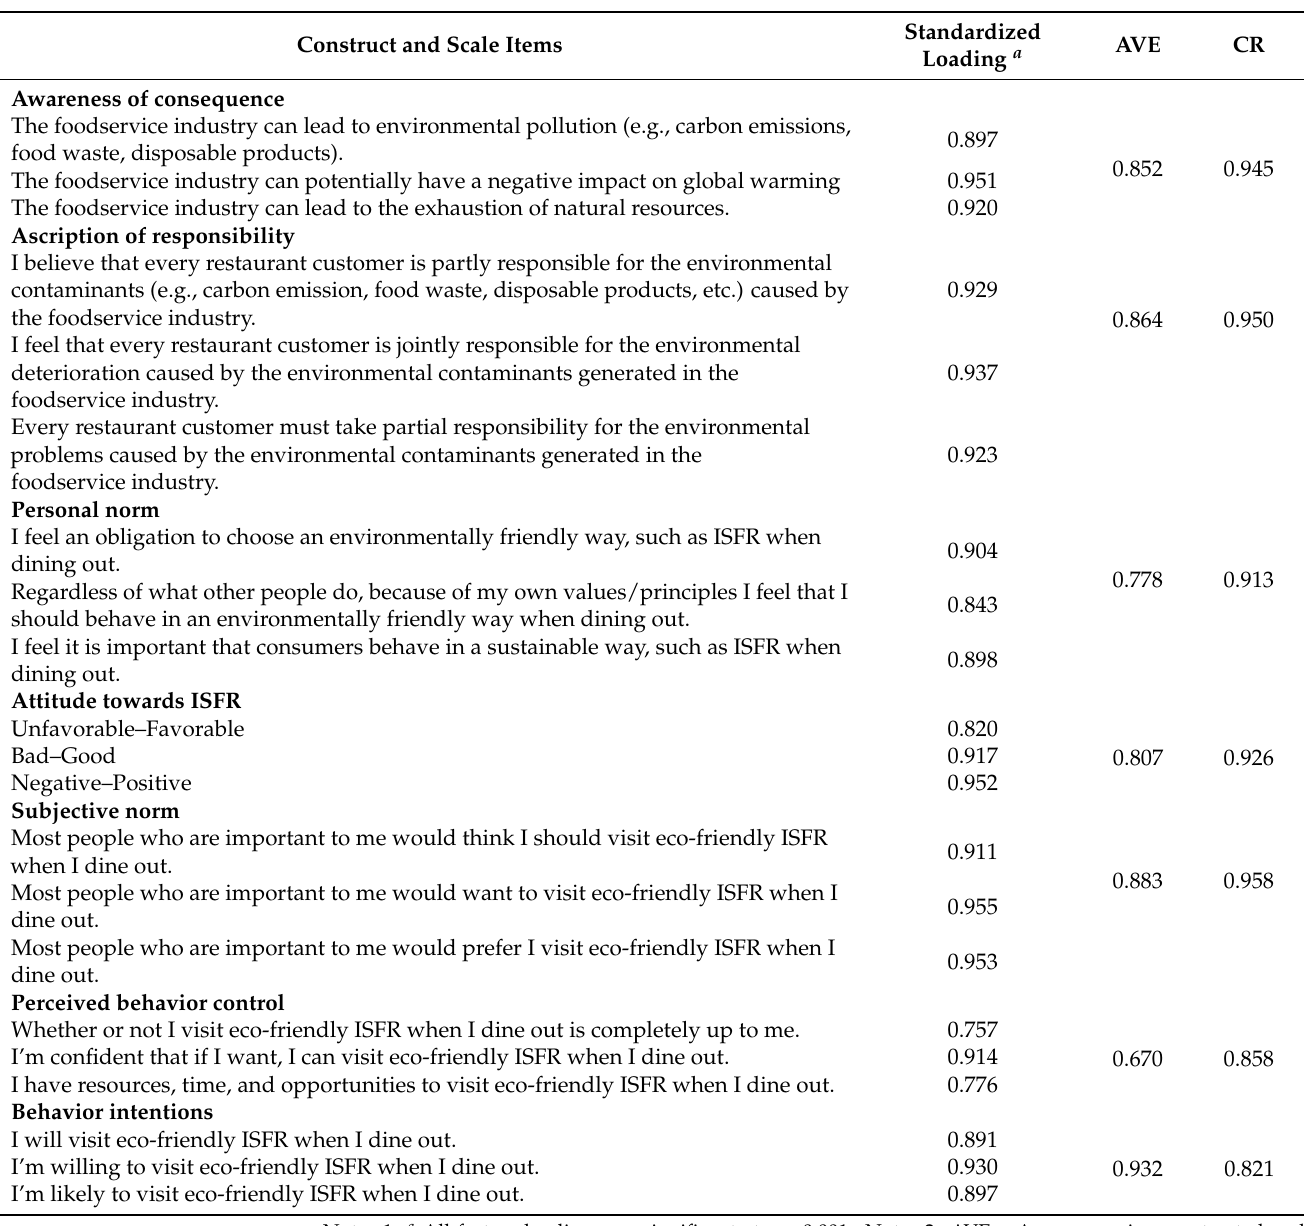
Table 2. Confirmatory factor analysis: items and